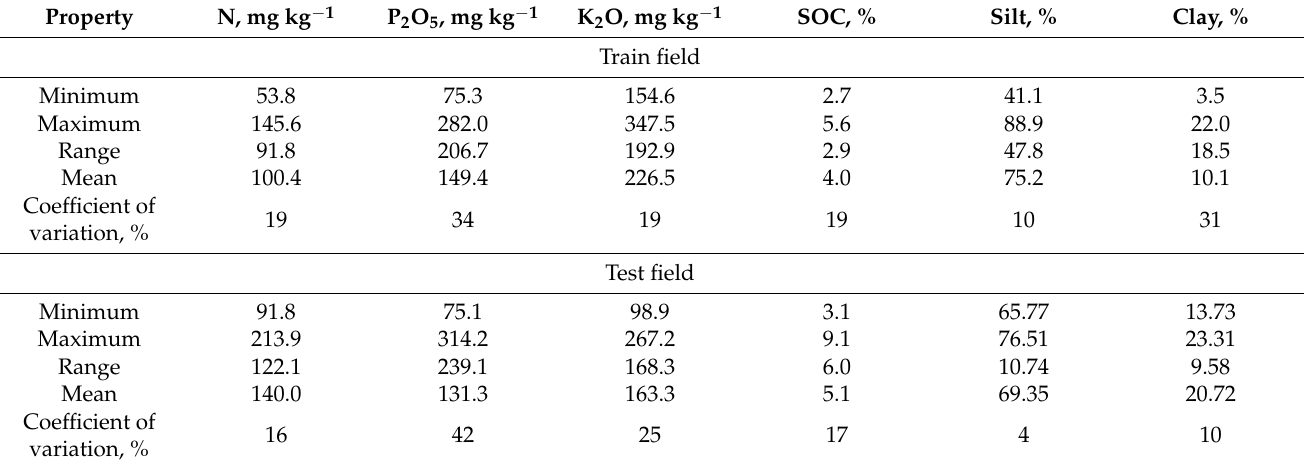
Table 2. Descriptive statistics of soil